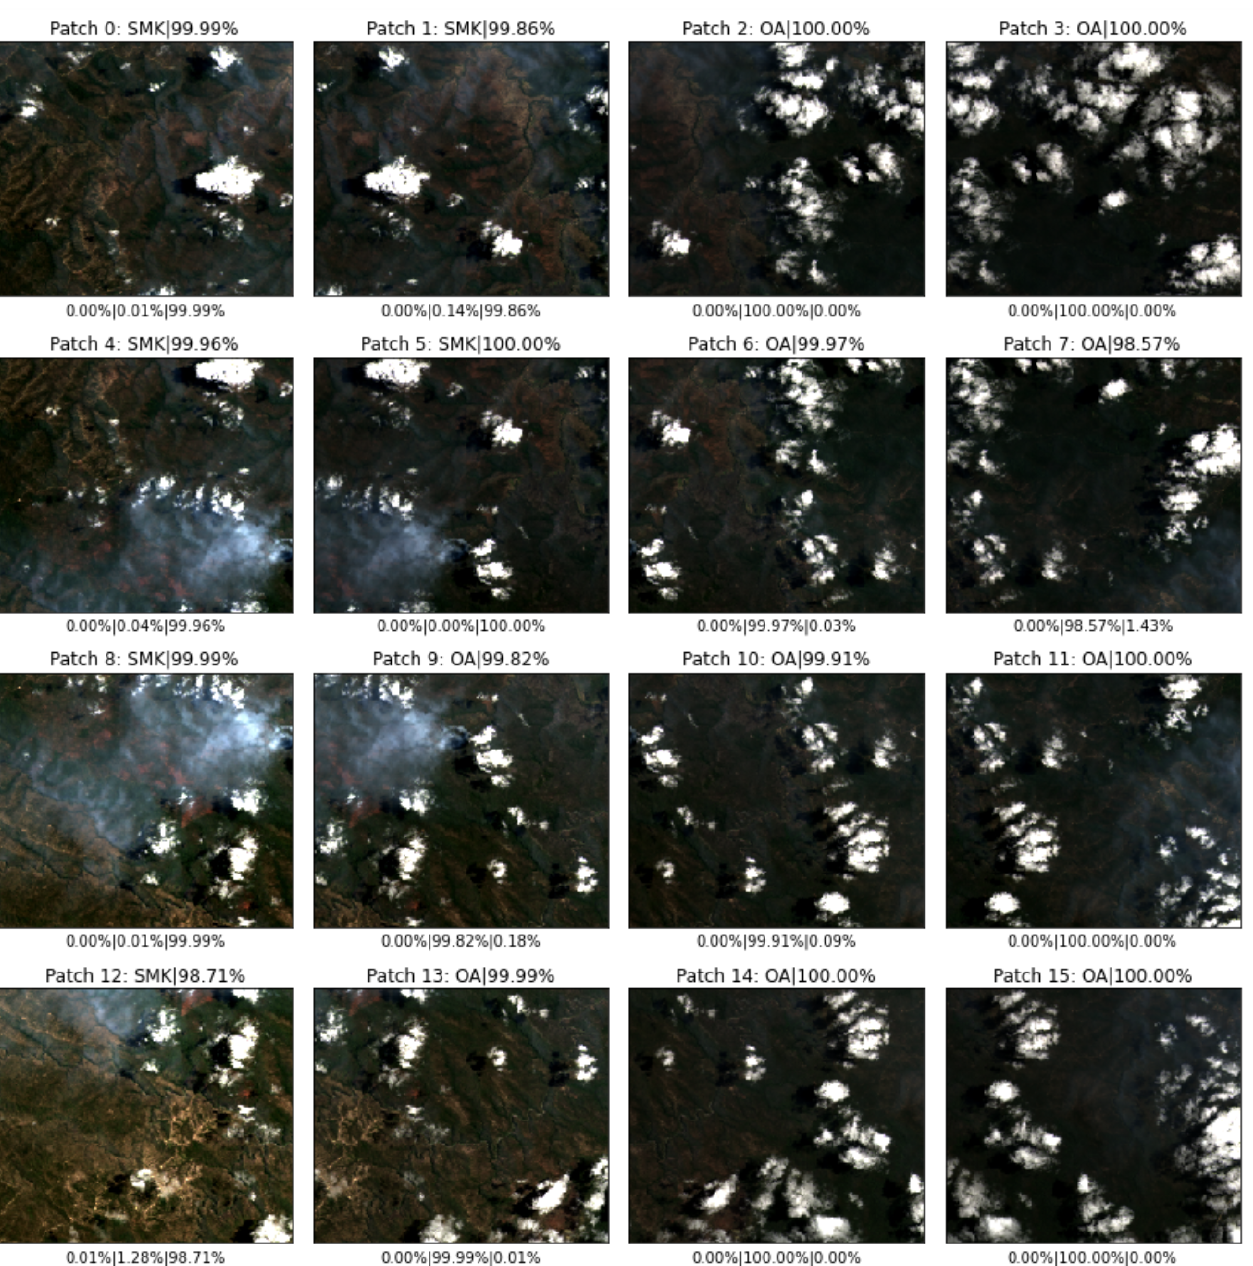
Figure 11. Prediction results of scene (b) in Figure